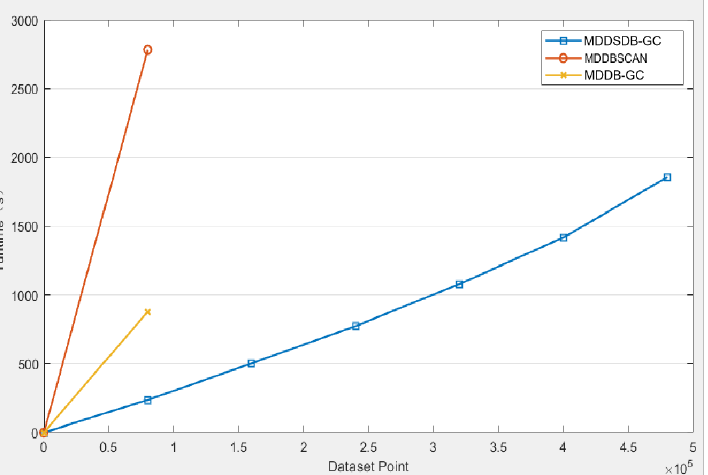
Figure 10. Comparison of computational efficiency between MDDSDB-GC algorithm and original multi-density DBSCAN